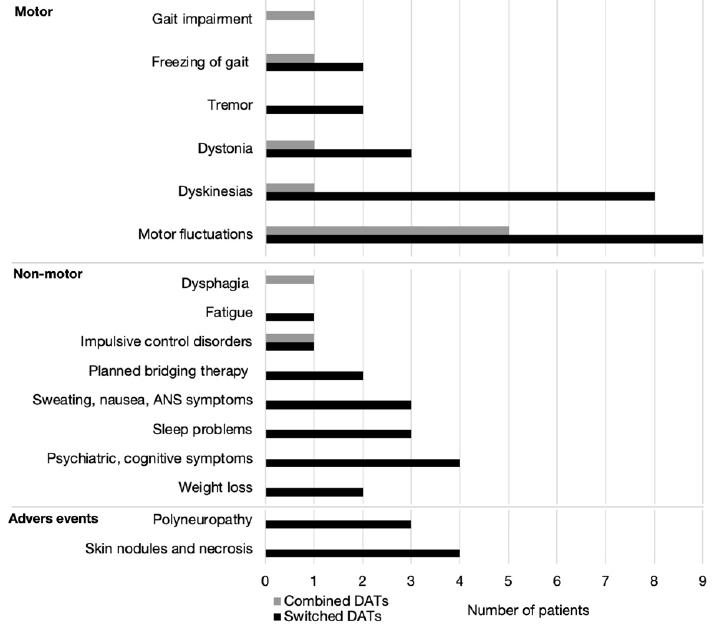
Figure 2. Motor and non-motor reasons and adverse events for switching between (black bars) or combining (gray bars) device-aided therapies (DAT) (y-axis). X-axis—number of patients. Non-motor causes were much less frequently the reason for switching DATs. Psychi- atric and cognitive complains were the reason for switch in four patients, sweating, nau- sea, and other autonomic nervous system problems in three, sleep problems in three, weight loss in two patients on LCIG, punding in one, and fatigue in another one. Likewise, in patients on combined DAT only two non-motor reasons in two patients, were observed: dysphagia in one and DDS in another. Adverse events, skin nodules in three and skin necrosis in one patient on CSAI and polyneuropathy in three patients on LCIG, were also reasons for switching between therapies. 4. Discussion Our results show that the overall rate of switching between DATs or combined DATs is rather low at 6.0%, implying that DATs are efficient in the vast majority of aPD patients. Most of the needed switches were from CSAI to either STN-DBS or LCIG, followed by switches from LCIG to either STN-DBS or CSAI. Only two of the patients switched from STN-DBS: one to LCIG and another one to CSAI first and then to LCIG. Six patients were identified with combined therapies, all of whom had STN-DBS as their first DAT. GI 6 months after initiation of the first and second switched or added DAT was similar, argu- ing that switching or adding DAT is warranted in patients in whom the beneficial effect either wanes or is insufficient. 4.1. Switching between DATs The age at PD onset and age at 1st and 2nd DAT were highest in patients who switched from CSAI to LCIG and lowest in those who switched from CSAI to STN-DBS. Because CSAI is the least invasive, patients often choose it first. The duration of CSAI